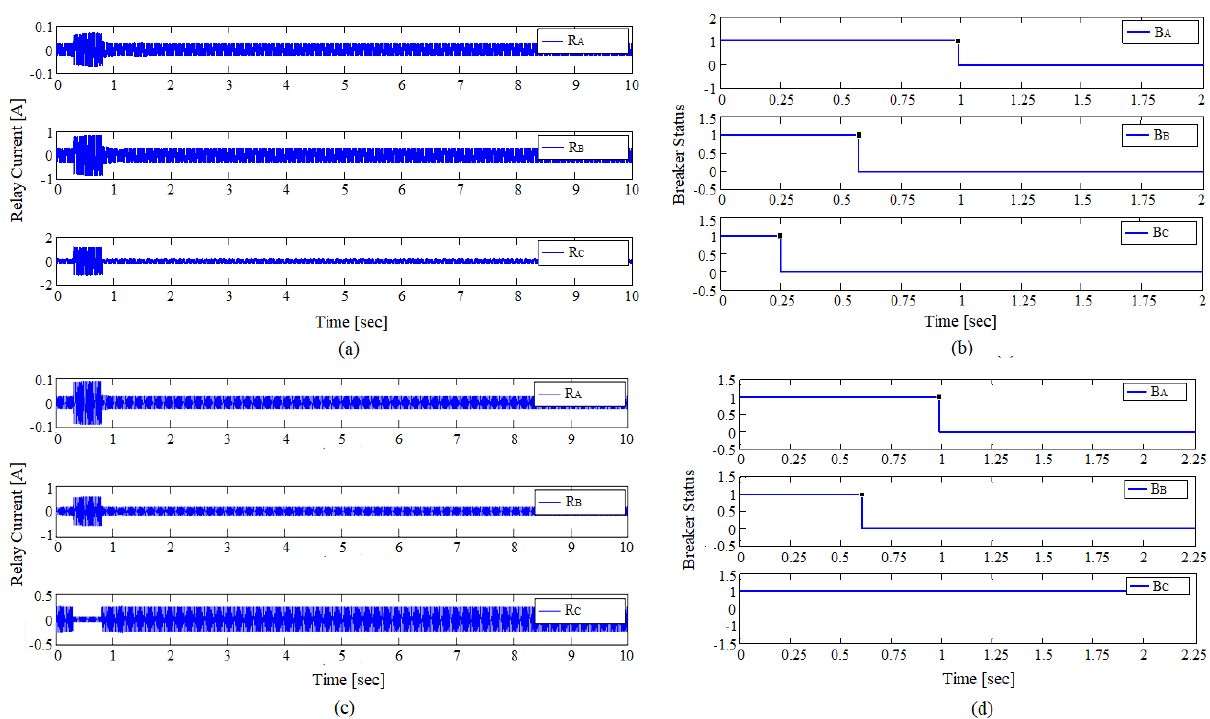
Figure 12. Relay current and breaker status under normal and faulty conditions, ( a , c ) magnitude of currents flowing through all the installed relays during normal and three phase (symmetrical) and single phase to ground (asymmetrical) faults, respectively, ( b , d ) tripping status of corresponding breakers during normal and three phase (symmetrical) and single phase to ground (asymmetrical) faults,